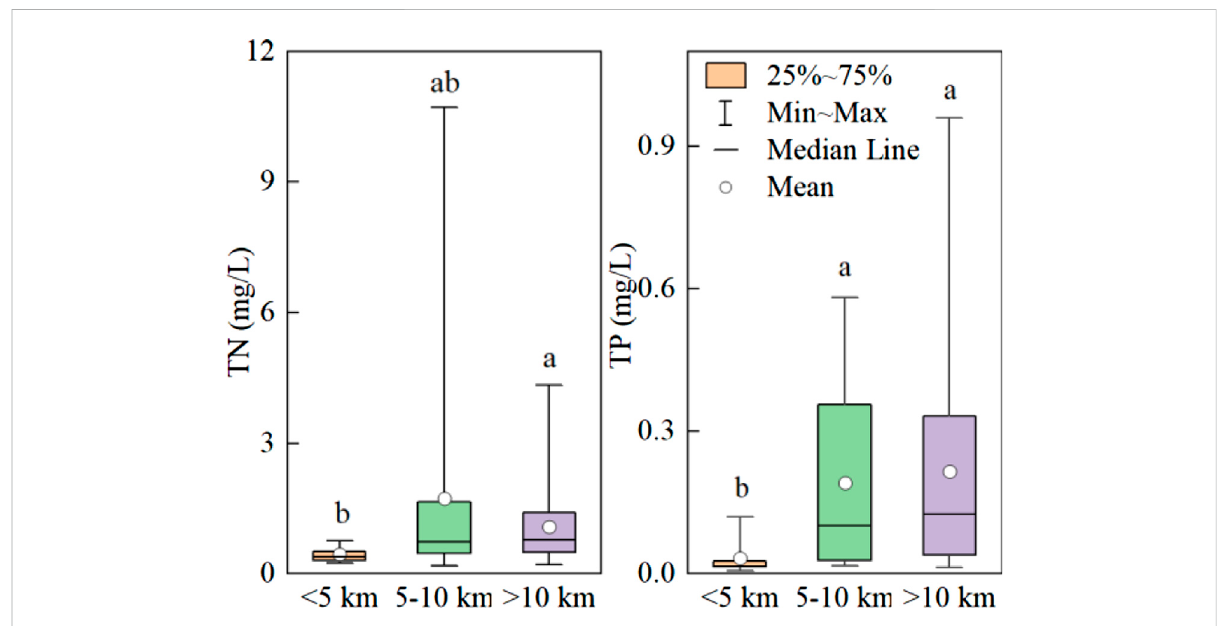
FIGURE 4 N and P concentrations in small water bodies in different distance bands in